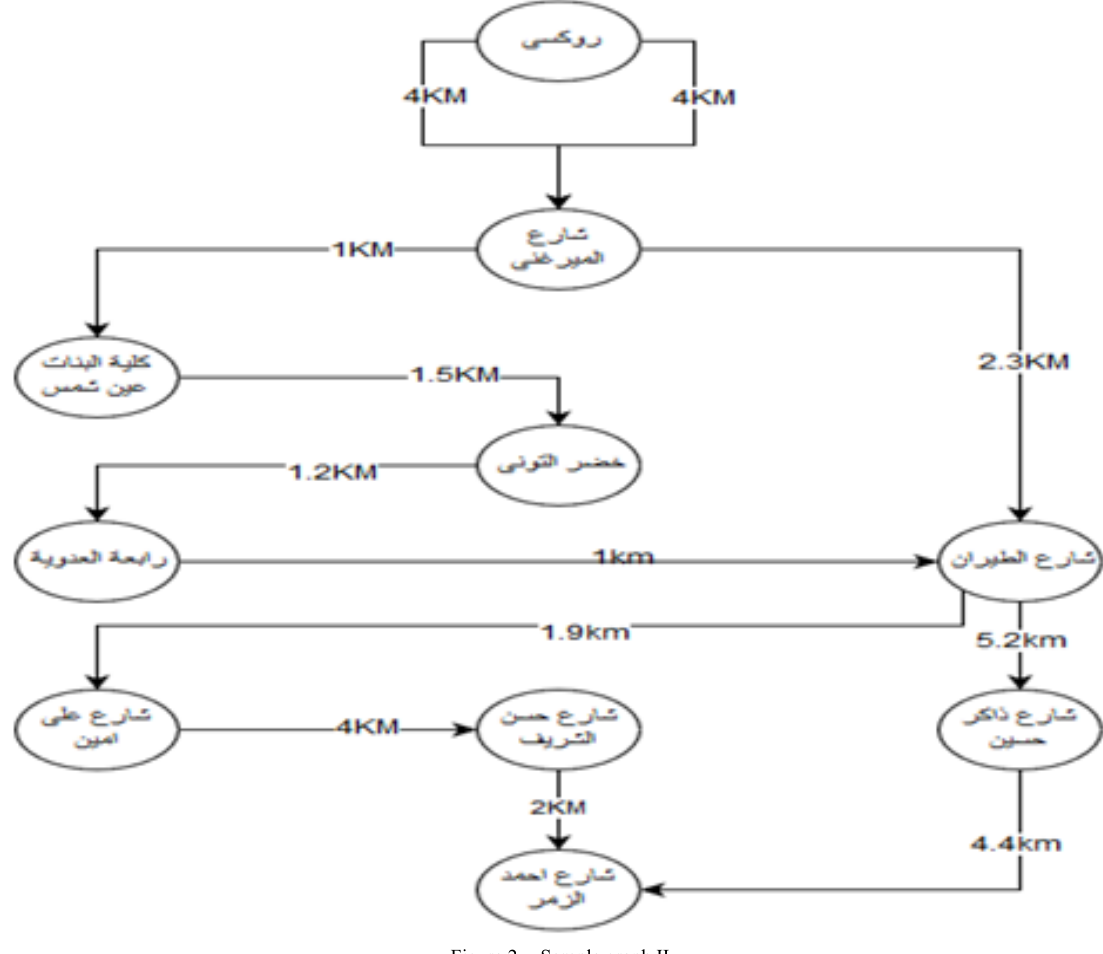
Figure 2. Sample graph